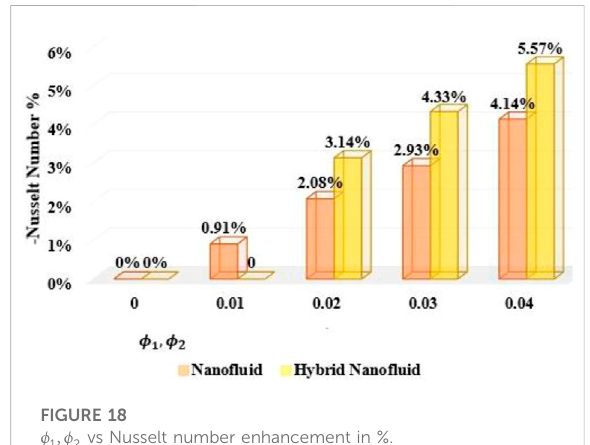
FIGURE 15 In fl uence of γ c on Φ ( η ) .